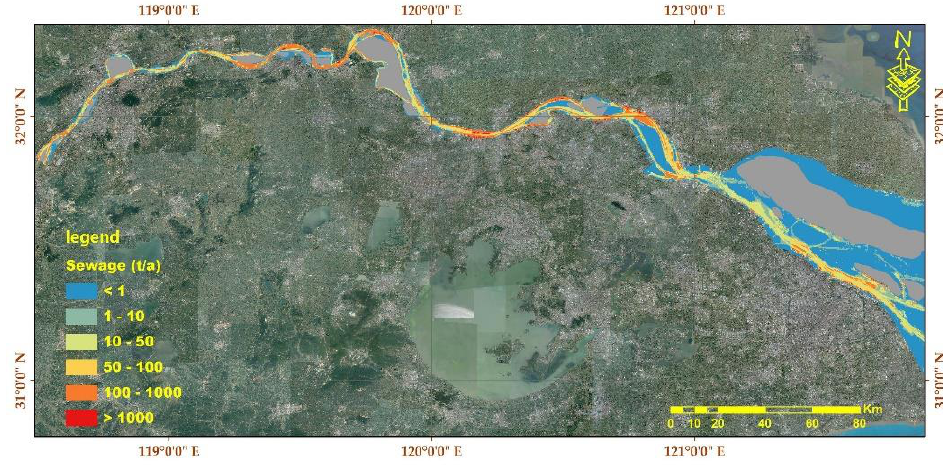
Figure 6. Domestic sewage generation.